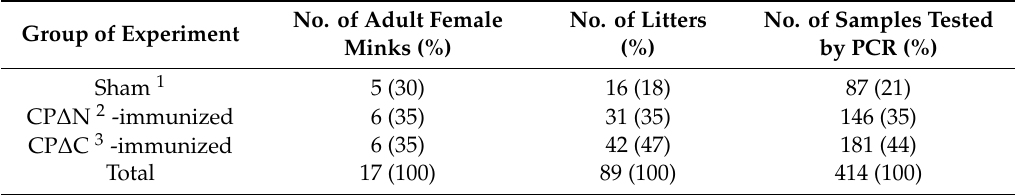
Table 1. Summarizing the data of various groups in the mink trial.